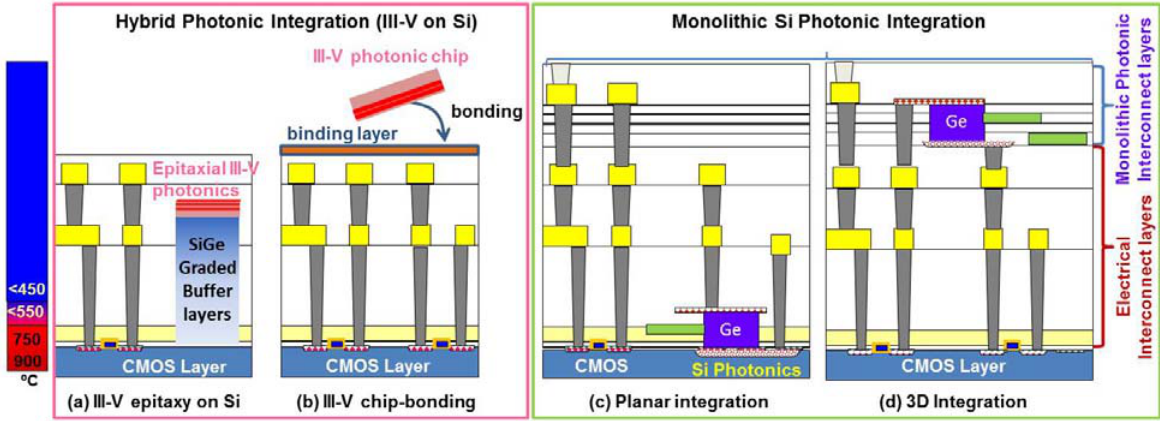
Figure 1. Schematics of hybrid photonic integration vs. monolithic Si photonic integration. Hybrid integration with III-V semiconductors includes ( a ) III-V epitaxy on Si, and ( b ) chip-bonding of III-V on Si. Monolithic Si photonic integration includes ( c ) Planar integration of Si photonics with complementary metal oxide semiconductor (CMOS) circuits on the same layer, and ( d ) 3D photonic integration with the photonic interconnect layer positioned well above the CMOS layer. In (c) and (d), waveguide-coupled Ge photo detectors are shown as examples of CMOS-compatible, monolithic photonic devices. The color bar on the left shows the processing temperature in different